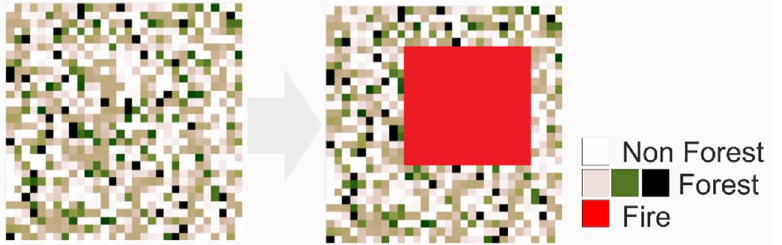
Figure 2. Fire model according to Drossel–Schwabl. On the left is a representation of the cellular automaton, consisting of vegetation (green) and empty cells (white). On the right is the spread of a fire event (red). In this schematic visualization of a virtual landscape, one cell has the size of 20 m, and the total area is 30 × 30 cells.